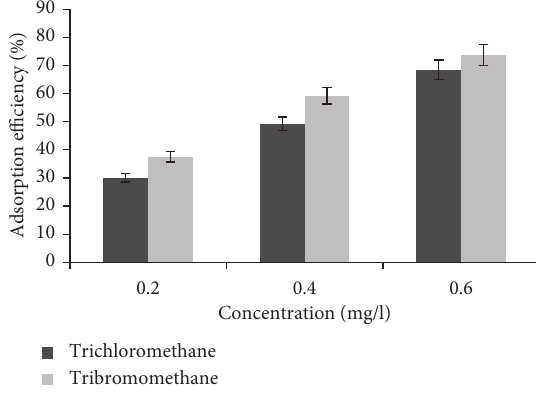
Figure 6: Effect of initial concentration on adsorption of tri- chloromethane and tribromomethane in simulated experiment.